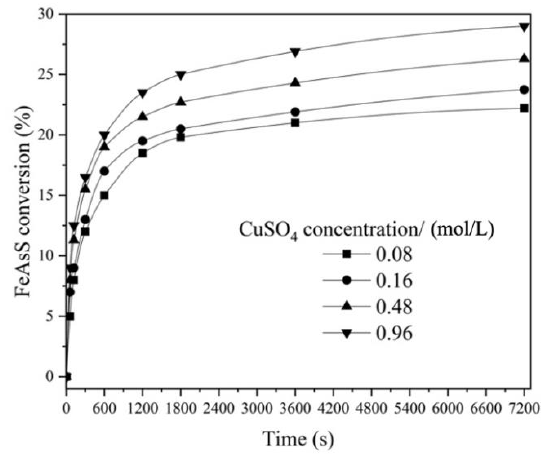
Figure 6. Effect of CuSO 4 concentration on hydrothermal conversion of FeAsS (100 rpm; 503 K; 0.1 mol/L of H 2 SO 4 ; 10 –29 μm).